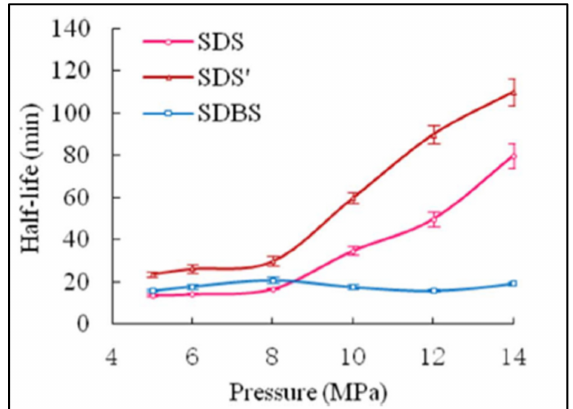
Figure 17. Stability of foam with differing surfactant properties against pressure (Reprinted with permission from Wang et al. [61]). Copyright 2017, Elsevier B.V.